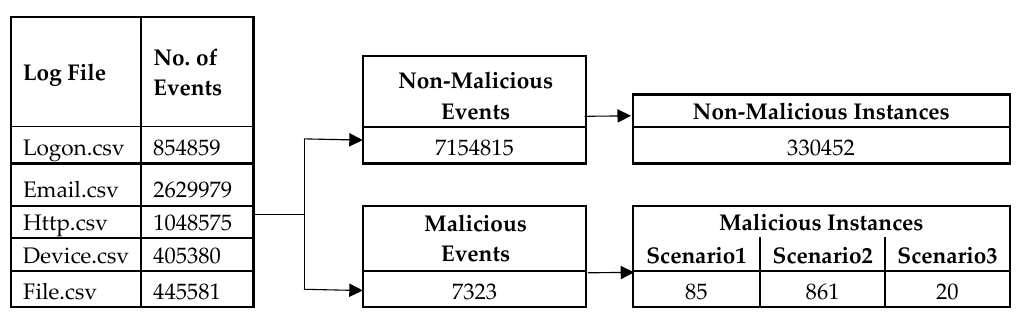
Table 3. Dataset details.